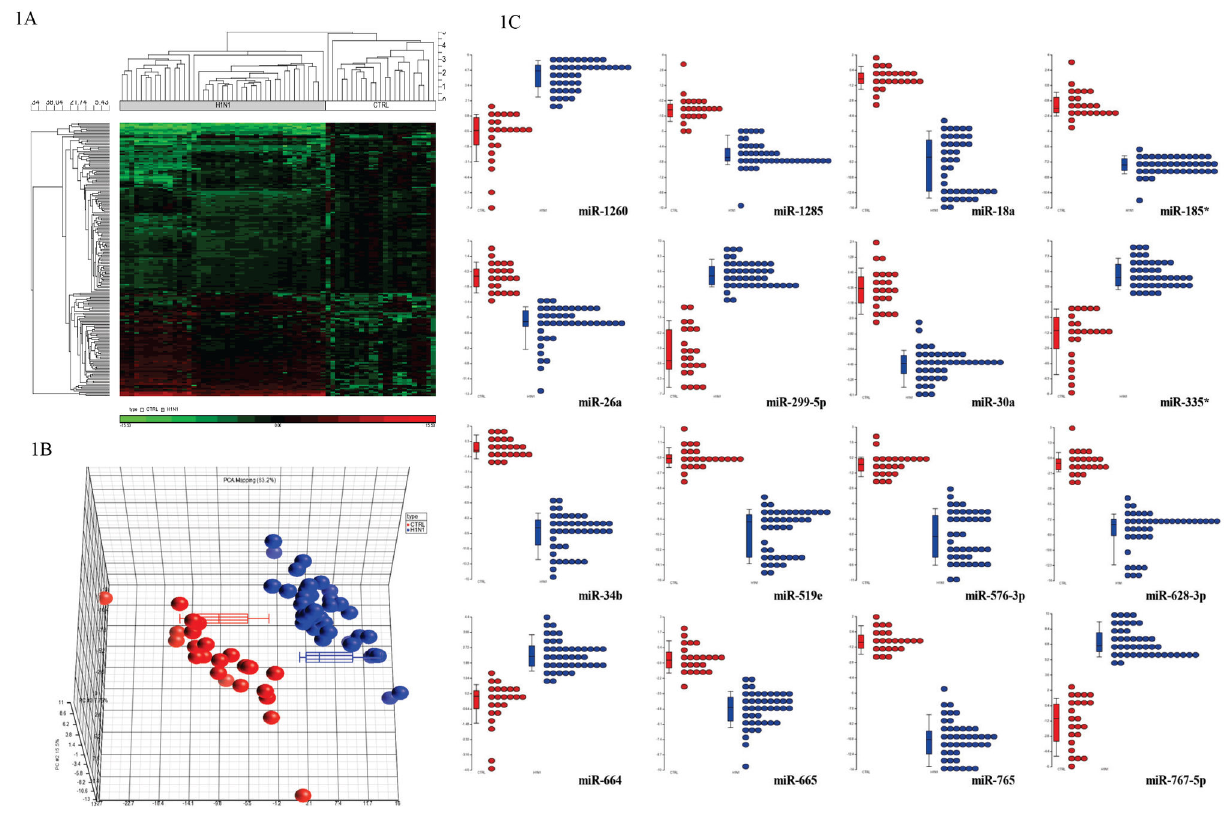
Figure 1. Analysis of microRNA profiles in healthy and influenza A patients. ( A ) Hierarchical clustering of miRNA profiles . 193 miRNAs were significantly dysregulated in influenza patients, providing a clear distinction of the pathology. The distinct clustering was seen between the miRNA profiles of the H1N1 patients and the healthy individuals. The upregulated genes are shown in red and downregulated genes are shown in green. ( B ) Principal Component Analysis (PCA) . PCA analysis reflected that although variation of miRNA profiles within H1N1 patients was evident, they were still clustered away from healthy individuals. Box-whisker plots also showed segregation of miRNA profiles between healthy individuals and those infected with H1N1. Red circles represent healthy individuals while blue represents H1N1 patients. ( C ) Dot plot profiles of selected 16 miRNAs . Distinct segregation was observed between the miRNA profiles of the H1N1 patients and the healthy individuals. Red circles represent healthy individuals while blue represents H1N1